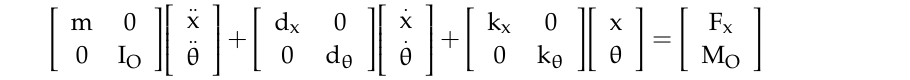
Figure A1. Crown wall movements. Adapted from the system proposed by Pedersen [2].